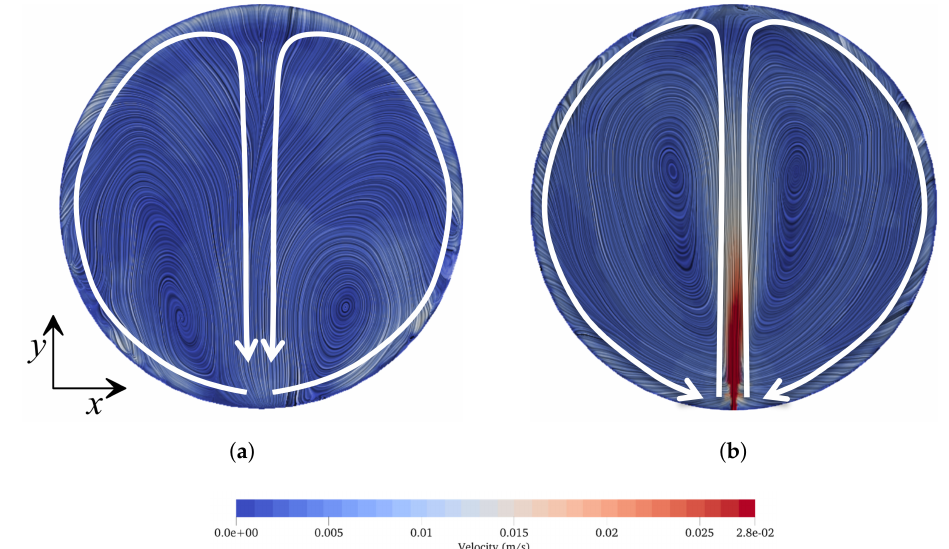
Figure 11. Flow pattern establishment and velocity fields at z = 0.5 H of the ( a ) plunging jet and ( b ) of the submerged